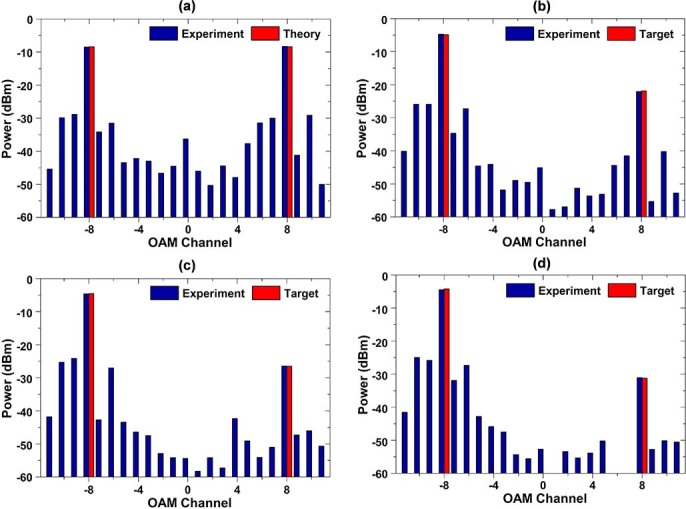
(a) Measured and theoretical power distributions for equalized power multicasting of OAM−8 and OAM8.(b)-(d) Measured and target power distributions for (b) 17-dB, (c) 22-dB and (d) 27-dB power difference multicasting of OAM−8 and OAM8.